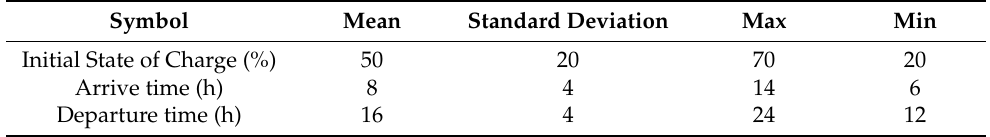
Table 1. Probability distribution of electric vehicle